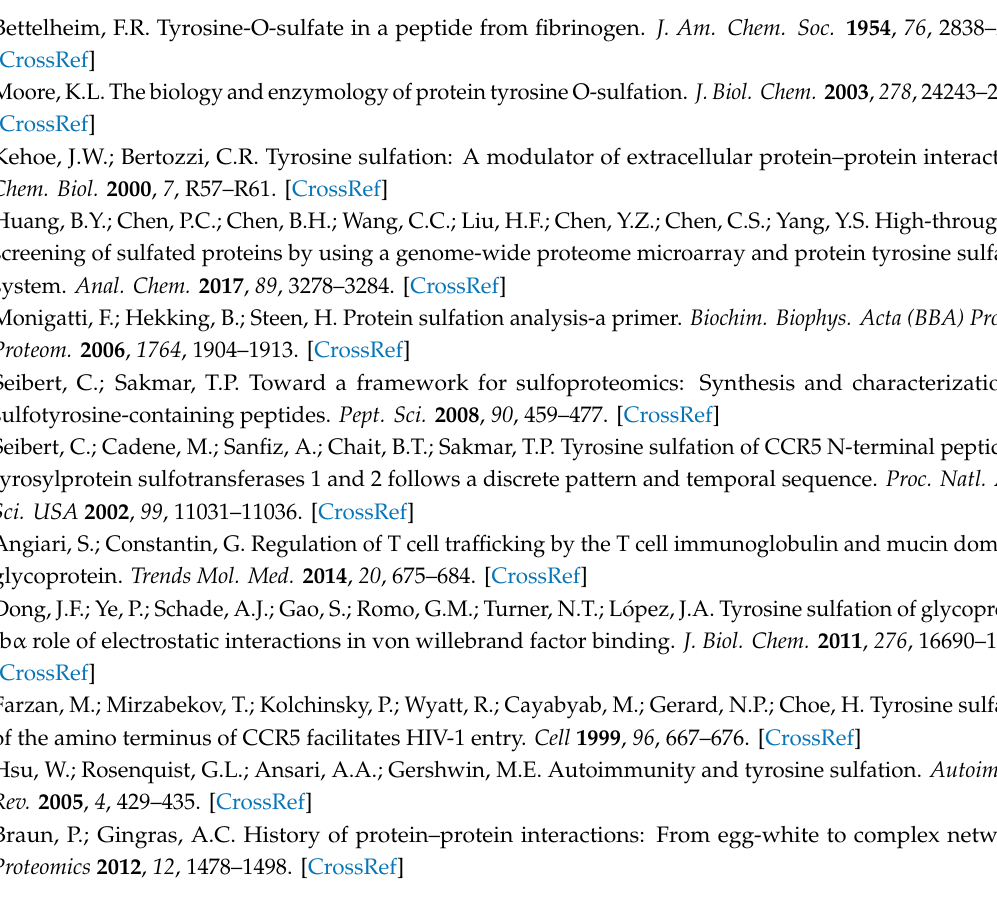
Figure S1: Schematic illustration of fabrication of Au nanoporous substrate, Figure S2: HR-FETEM image of optimized Au nanoporous substrate and EDS mappings of areas marked in HR-FETEM image, Figure S3: SPR spectra of as-fabricated Au nanoporous substrate created at deposition rates of (a) 0.3 Å / s and (b) 1 Å / s with optimized dealloying times (120 and 150 s, respectively). (c) COMSOL calculation of smooth and roughed Au nanocavity, Figure S4: Relationship of relative Raman intensities for various mutants and antibody-sulfotyrosine interactions on Au nanoporous substrate determined using ISERS peak regions at 990–1010 and 1601–1636 cm − 1 , Figure S5: VP1 of EV71 on Au nanoporous substrate examined at Raman laser wavelength of 633 nm, Table S1: Nanopore size and contact angle of as-fabricated Au nanoporous substrates, Table S2: Raman assignment for protein immobilized on Au nanoporous substrate [1–12], Table S3: Raman assignment for protein mutants on Au nanoporous substrate [1–12], Table S4: Raman assignment for protein-antibody interaction on Au nanoporous substrate [1–13], Table S5: Raman assignment for PPIs on Au nanoporous substrate